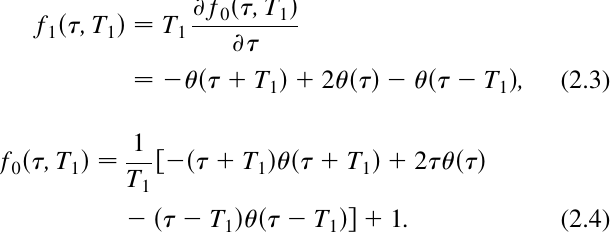
(cid:4) (cid:5); T (cid:5) (cid:1) 1 1